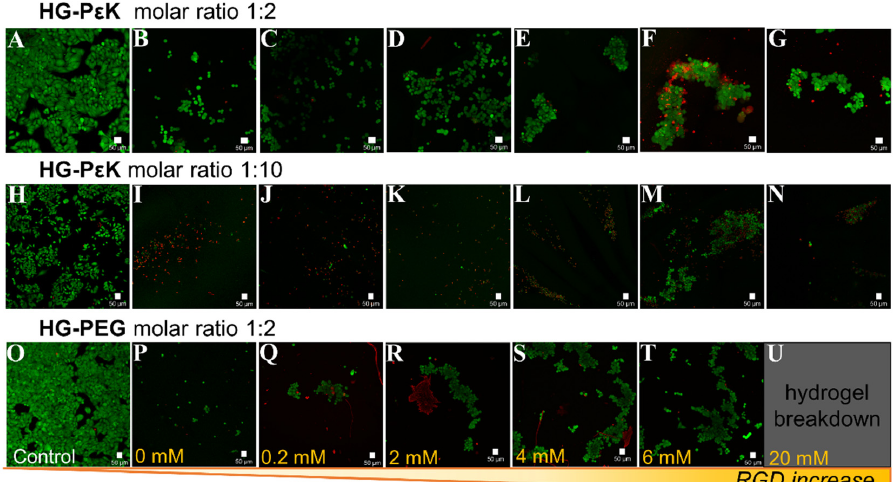
Figure 4. Live/dead cell viability staining of HeLa cells seeded on a dynamic hydrogel array with varying levels of the peptide RGD. HeLa cells were seeded and incubated with complete DMEM for 48 h at 37 °C and 5% CO 2 before imaging on ( A , H , O ) tissue culture plate, ( B ) HG-P ε K molar ratio 1:2 with 0 mM RGD, ( C ) HG-P ε K molar ratio 1:2 with 0.2 mM RGD, ( D ) HG-P ε K molar ratio 1:2 with 2 mM RGD, ( E ) HG-P ε K molar ratio 1:2 with 4 mM RGD, ( F ) HG-P ε K molar ratio 1:2 with 6 mM RGD, ( G ) HG-P ε K molar ratio 1:2 with 20 mM RGD, ( I ) HG-P ε K molar ratio 1:10 with 0 mM RGD, ( J ) HG-P ε K molar ratio 1:10 with 0.2 mM RGD, ( K ) HG-P ε K molar ratio 1:10 with 2 mM RGD, ( L ) HG-P ε K molar ratio 1:10 with 4 mM RGD, ( M ) HG-P ε K molar ratio 1:10 with 6 mM RGD, ( N ) HG-P ε K molar ratio 1:10 with 20 mM RGD, ( P ) HG-PEG molar ratio 1:2 with 0 mM RGD, ( Q ) HG-PEG molar ratio 1:2 with 0.2 mM RGD, ( R ) HG-PEG molar ratio 1:2 with 2 mM RGD, ( S ) HG-PEG molar ratio 1:2 with 4 mM RGD, ( T ) HG-PEG molar ratio 1:2 with 6 mM RGD, and ( U ) HG-PEG molar ratio 1:2 with 20 mM RGD. Live cells are in green and dead cells are in red. Scale bars are 50 µm.